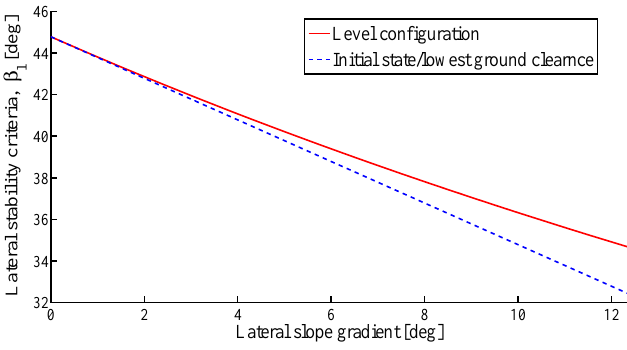
Figure 12. Lateral stability of leveled configuration.